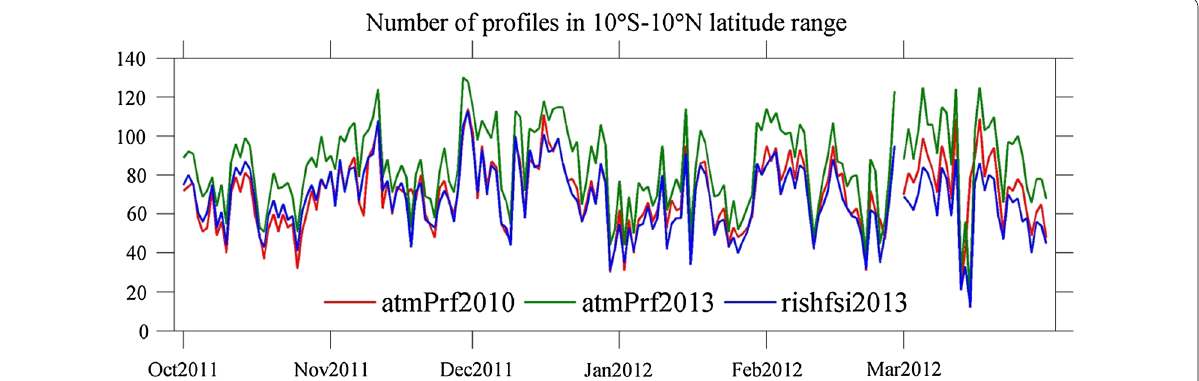
Fig. 1 Number of COSMIC GPS-RO profiles retrieved by atmPrf2010 ( red ), atmPrf2013 ( green ) and rishfsi2013 ( blue ) in 180°E–180°W and 10°S–10°N from October 1, 2011, to March 31, 2012. Tick marks on the horizontal axis indicate the first day of the corresponding month